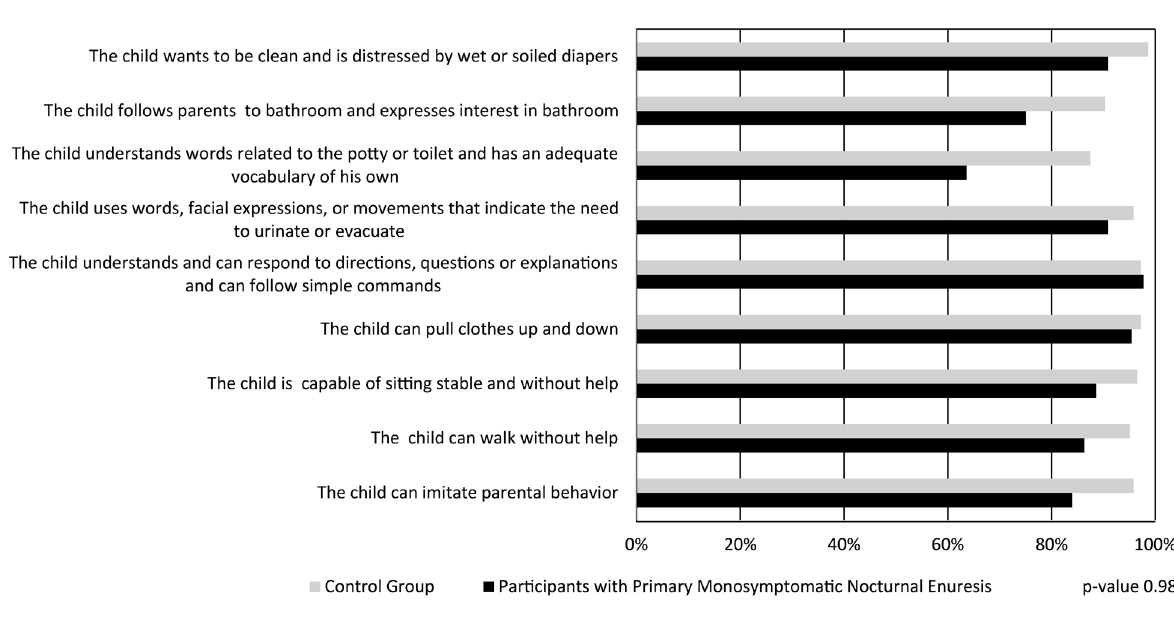
Figure 1 - Main readiness signs described by